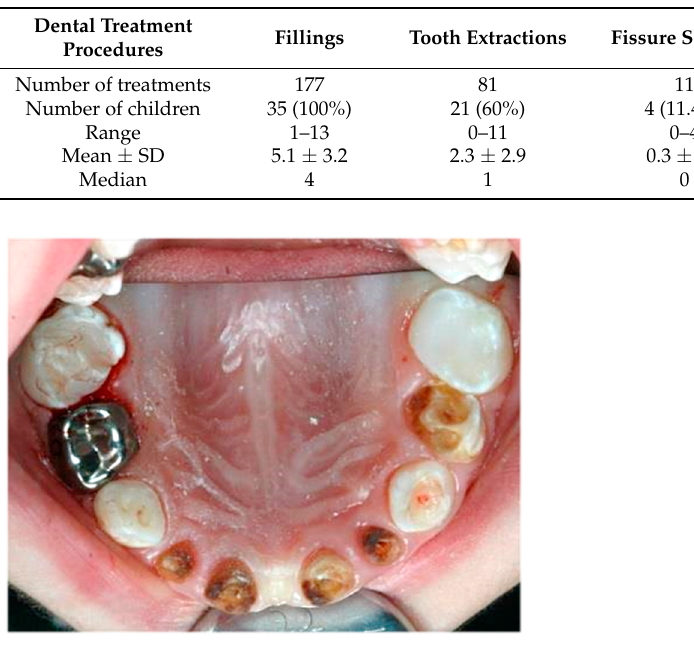
Table 3. Dental procedures performed under general anaesthesia.